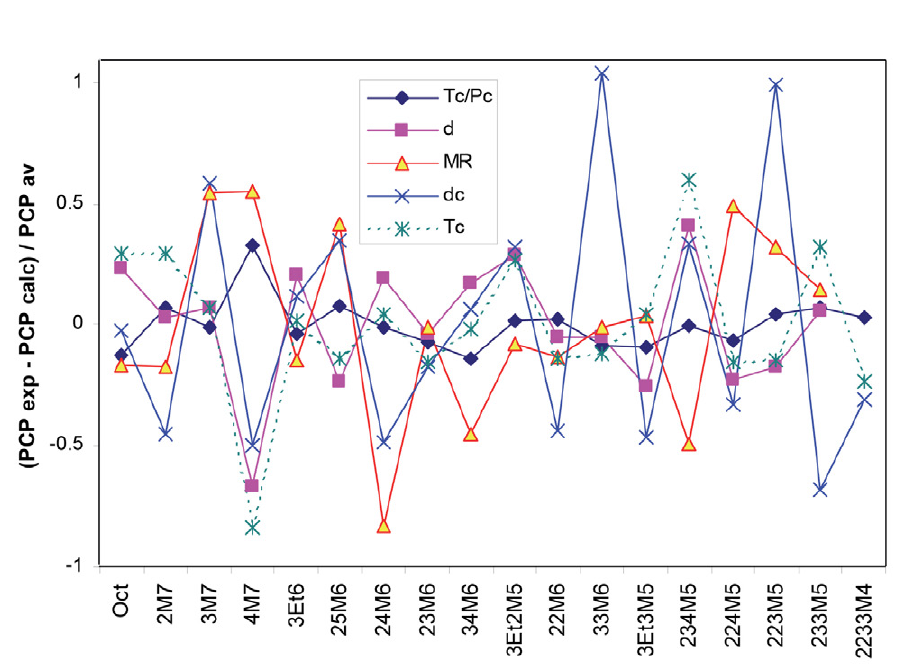
Figure 2. Reduced differences between the experimental values of the physicochemical properties of octanes and the values calculated using mutu- ally optimized contribution of all the tested Structural